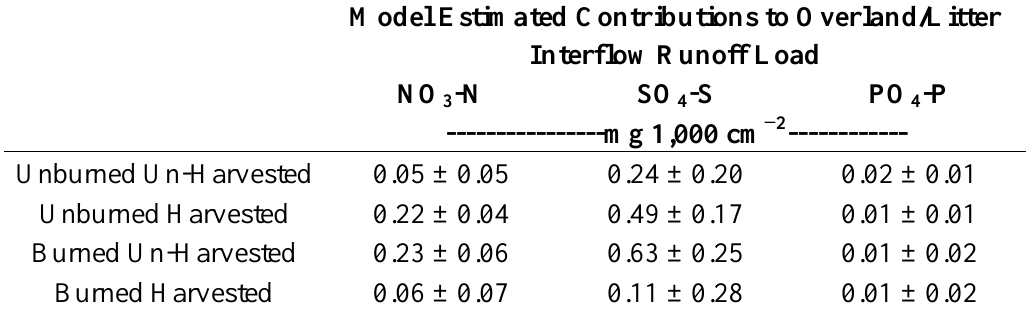
Table 4. Comparison of average estimates for nutrient load contributions (95% confidence) per runoff sample as affected by treatment. Load in mg per 1,000 cm 2 = 0.1 kg ha − 1 equivalent